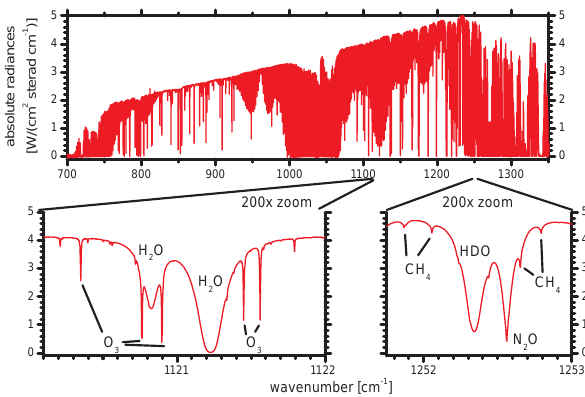
Fig. 1. Upper panel: Spectrum measured by the FTIR with the 700–1350cm − 1 filter setting and an integration time of 8min. Bot- tom panels: Zoomed in spectral microwindows containing H 2 O and HDO signatures. The spectrum was recorded on 25 July 2005 at 11h30 UT (local noon is at 13h10UT), with 0 . 005cm − 1 spectral resolution, for 47 ◦ , solar elevation, and 4 . 5mm